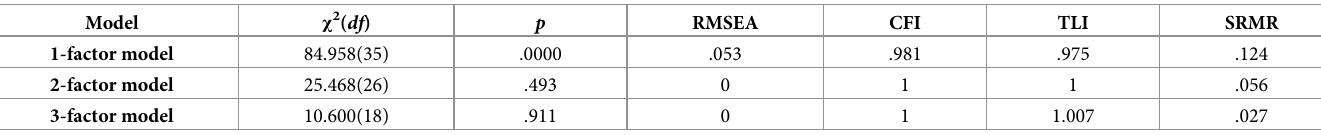
Table 2. Results from the exploratory factor analyses of the preliminary SHSI (N = 514). Model χ 2 ( df ) p RMSEA CFI TLI